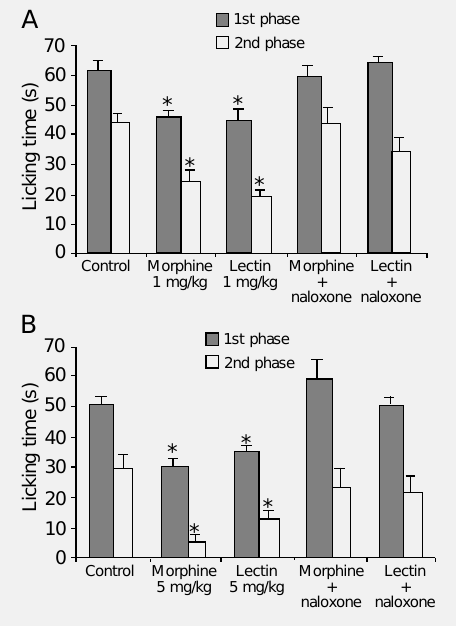
Figure 2. Role of the opioid system in the antinociceptive effects of lectins from Bryothamnion seaforthii (A) and B. triquetrum (B) in the formalin test in mice. Licking time (mean ± SEM) recorded for 5 to 16 mice. Animals received lectin fractions (1 and 5 mg/kg, ip ) in the absence and presence of naloxone (2 mg/kg, sc , injected 15 min before the lectin), 30 ( ip ) or 60 ( po ) min before the intraplantar administration of 1% formalin solution. Morphine (5 mg/kg, ip ) in the absence and presence of naloxone (2 mg/kg, sc , injected 15 min before morphine) was used as standard. Measurements were made during the first 5 min (1st phase) and after 20 min (2nd phase) for 5 min each time. *P<0.05 vs control